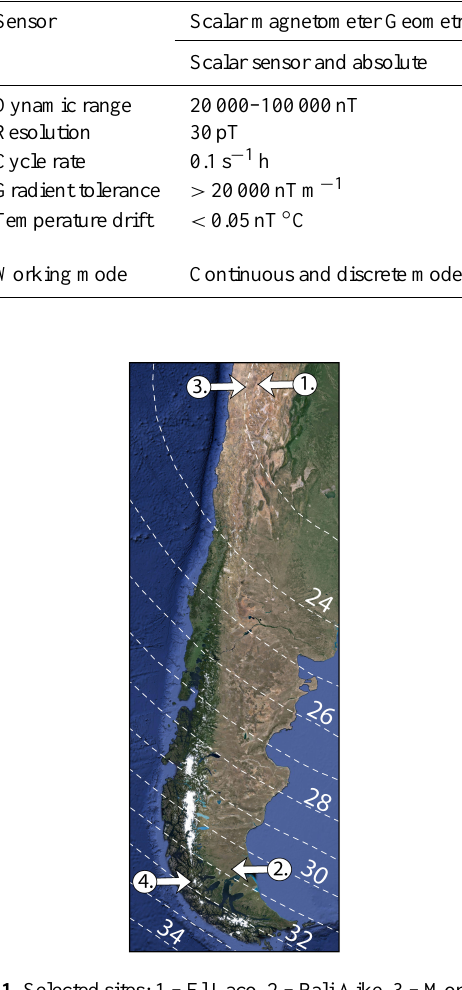
Table 1. Summary comparison between the MOURA and Geometrics 858 magnetometers.